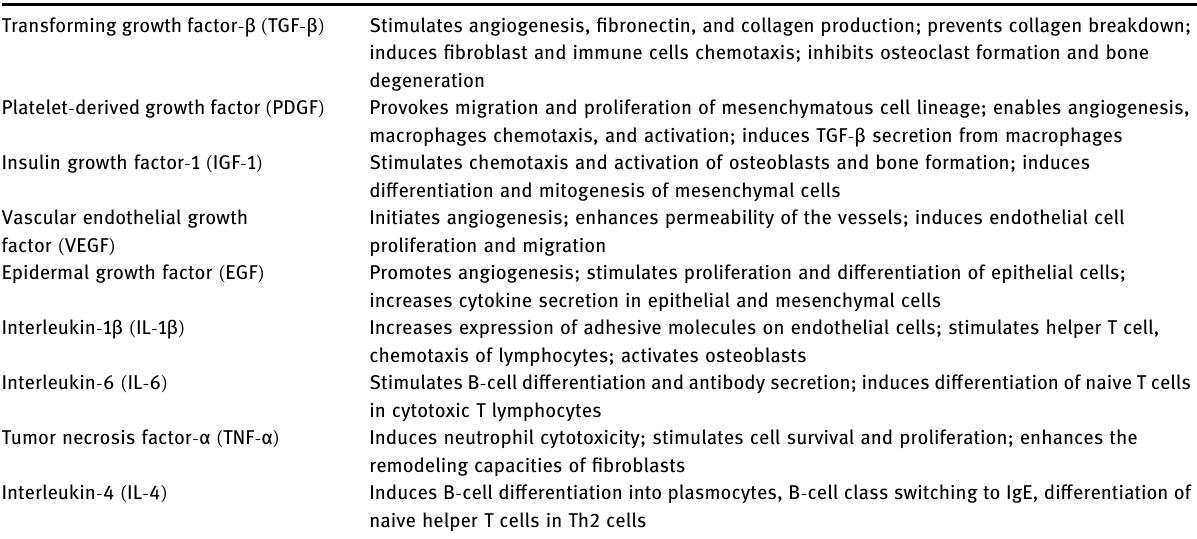
Table 2: Certain growth factors and cytokines present in PRF and their function Transforming growth factor - β ( TGF - β